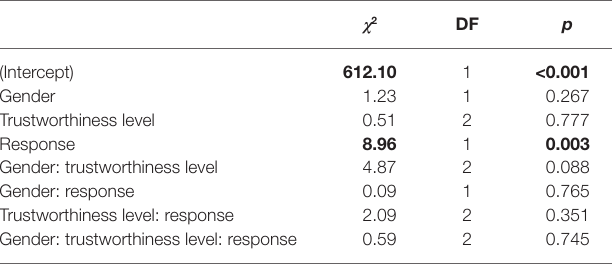
TABLE 9 | Omnibus test for effects of gender, trustworthiness level, and response on RTs.